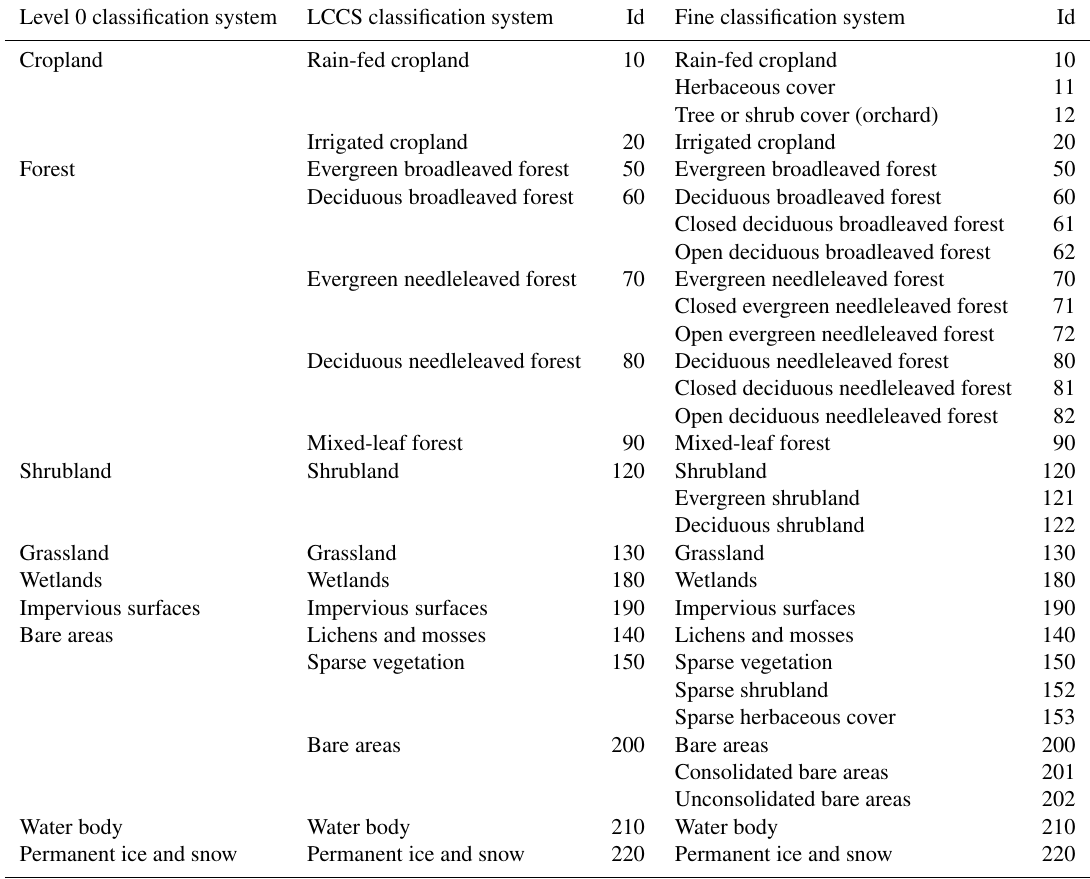
Table 2. The fine classification system and its relationships with other classification systems (LCCS and GlobeLand30 Level 0). Level 0 classification